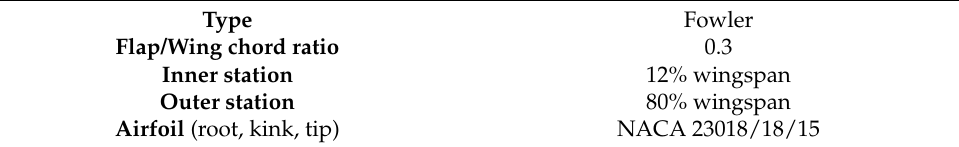
Table 9. Main flap